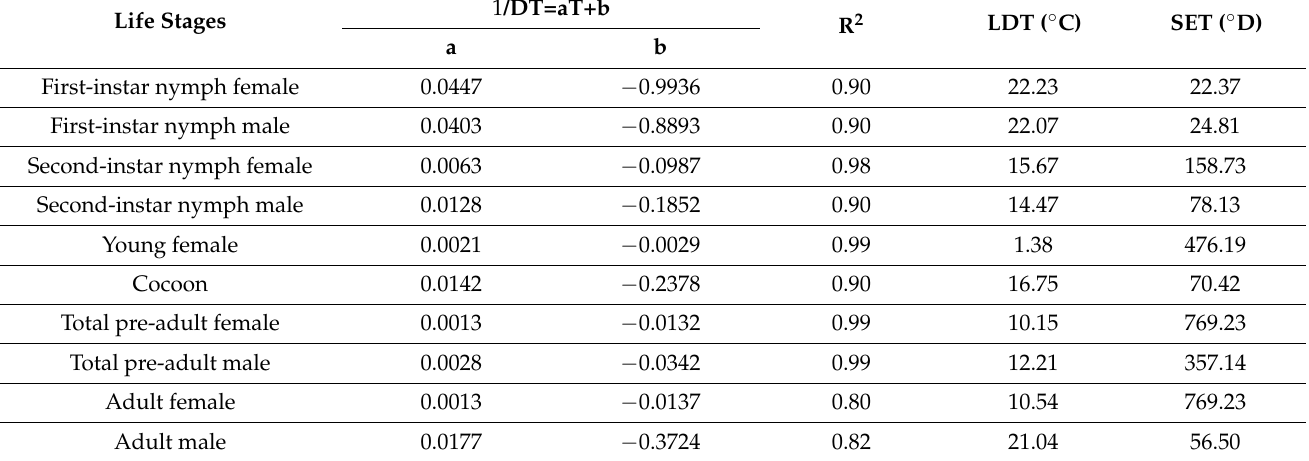
Table 6. Lower development threshold (LDT) and sum of effective temperatures (SET) required for the development of the different stages of D. opuntiae , with the respective coefficient of determination (R 2 ), slope (a), and intercept